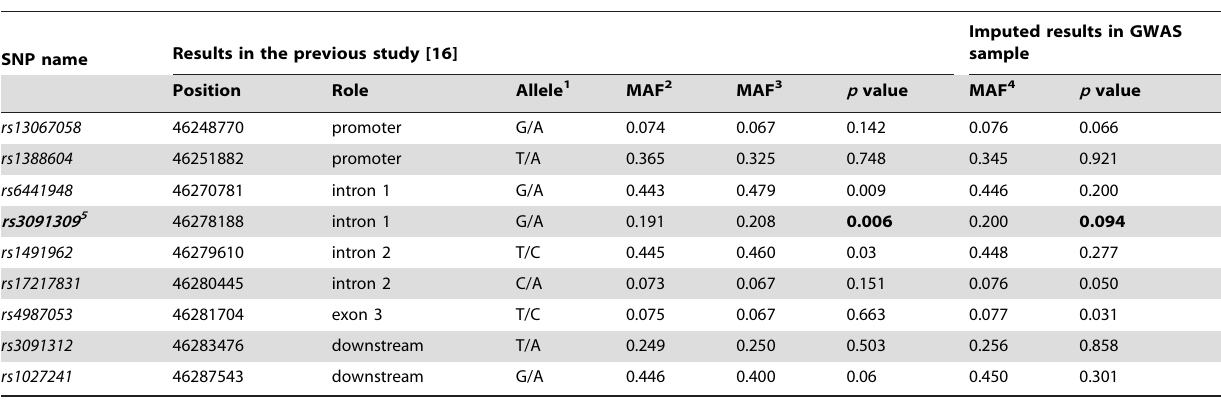
Table 6. Comparison between previous study and this GWAS for CCR3 gene’s association with